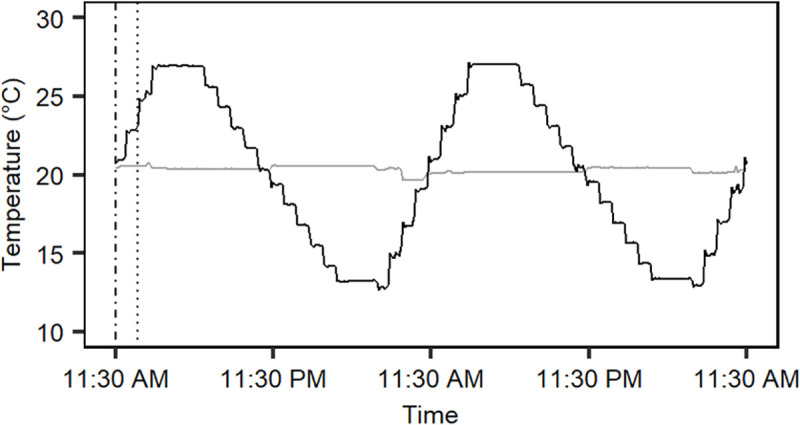
Thermal acclimation regimes.Section of the recorded temperatures in the constant (grey) and fluctuating (black) thermal regimes from the second experimental run. The constant thermal regime maintained a temperature of 20.4± 0.2°C and the fluctuating regime cycled around the mean temperature in intervals of 13.2–26.9°C. Adult flies, collembolans and plant seedlings were acclimated to each acclimation regime for 6–7 days. The experiment was performed twice and the dotted and dashed lines represent the temperature at the initiation of acclimation treatments in the first and second experimental run, respectively.